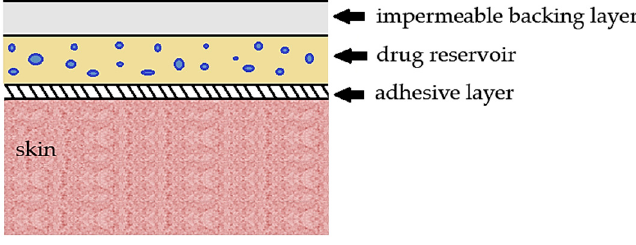
Figure 5. A sketch of a possible medicated patch.